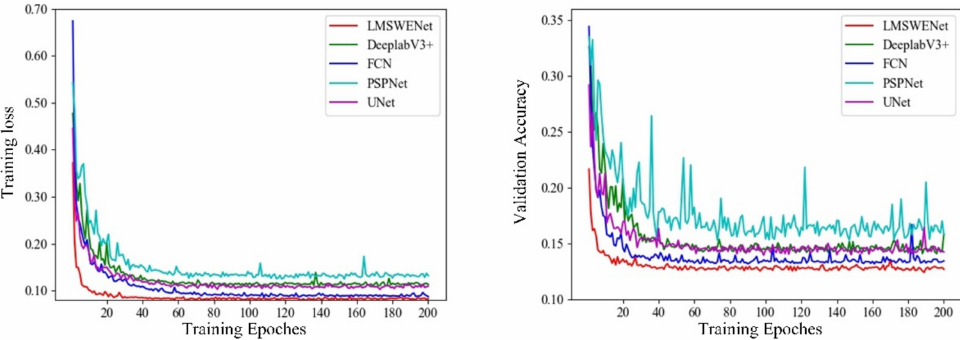
Figure 8. The loss curves of training and